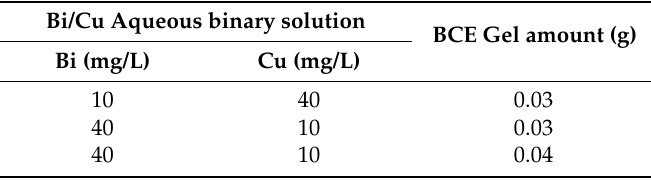
Table 2. Parameters for BCE hydrogel amounts and analyte concentrations for adsorption from binary metal ion competitive